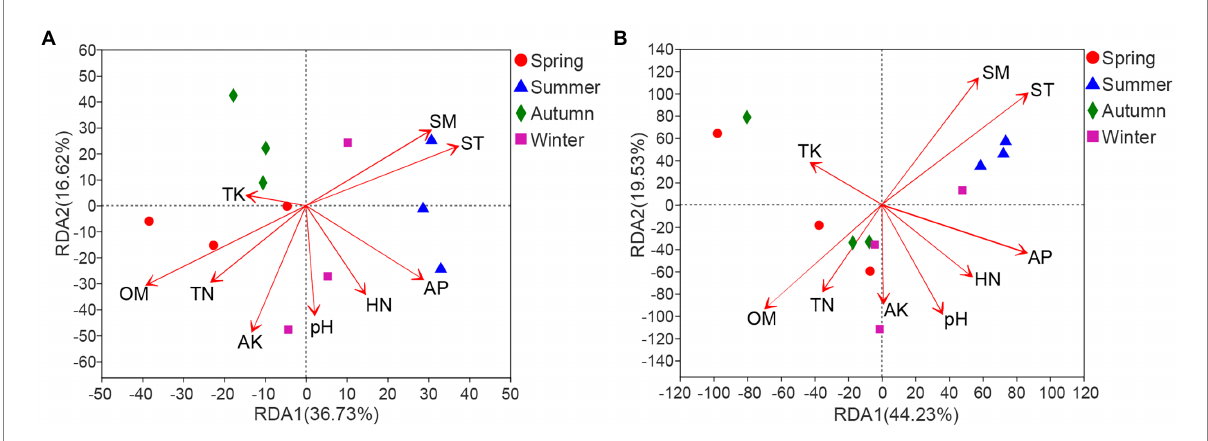
FIGURE 6 Redundancy analysis of soil properties and bacterial (A) or fungal (B) community in rhizosphere of C . pingbianense . TN, total nitrogen; TK, total potassium; HN, hydrolyzable nitrogen; AP, available phosphorus; AK, available potassium; OM, organic matter; ST, soil temperature; SM, soil